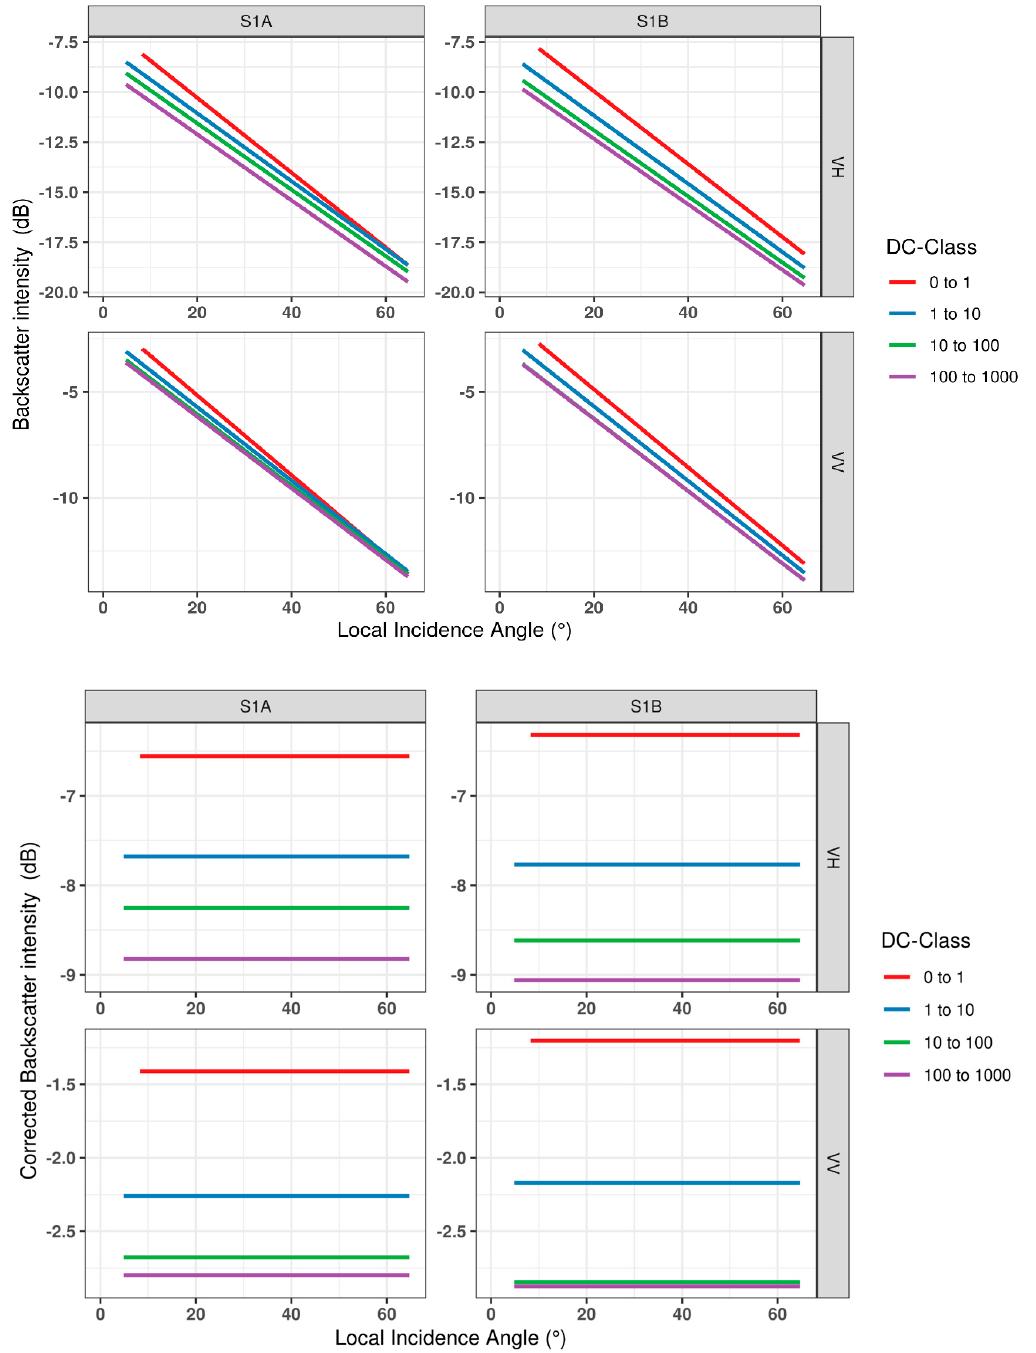
Figure 6. Relationship between the LIA and backscatter values ( top ) and corrected backscatter values ( bottom ) in unburnt pixels over canopy cover grouped by DC class.